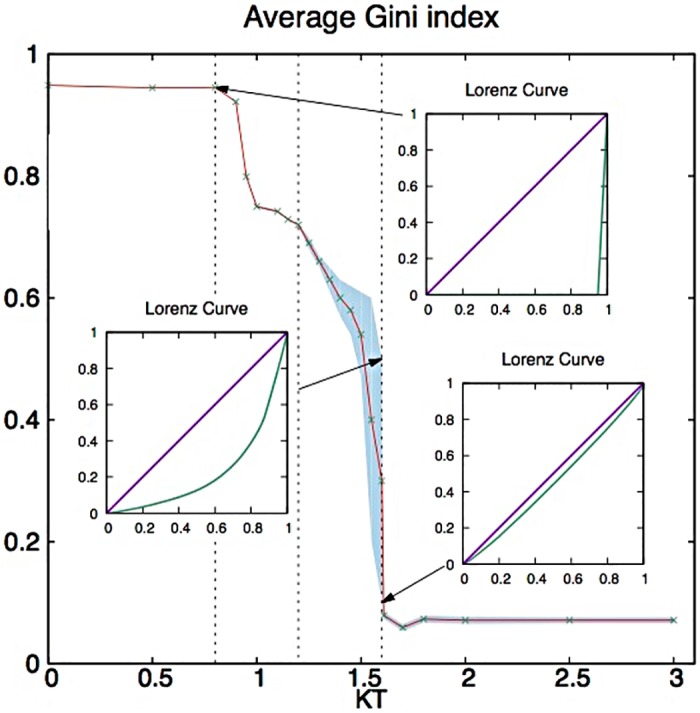
The mean Gini index as a function of initiative K (for T = 0.1), and its kinetic transitions (the blue shaded area corresponds to the periodic regime).The insets show the Lorenz curves at (KT = 0.8, G = 0.94), (KT = 1.6, G = 0.55) and (KT = 1.6, G = 0.09). The dashed lines distinguish four kinetic regimes: from left to right the power-dominated, the softened power, the periodic, and the egalitarian regimes.